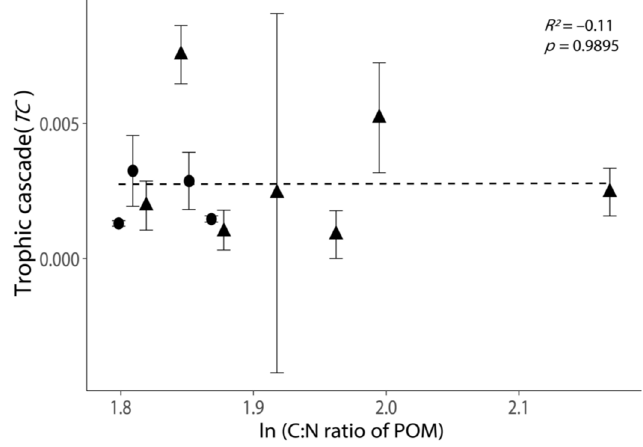
Figure 5. Relationship between the intensities of trophic cascades ( TC ) and the C: N ratio of POM. All values are shown as the mean ± 1 standard error. Negative values of TC were removed, as these experiments exhibited no trophic cascade. Triangular points indicate the TC calculated from the incubations with phytoplankton growth (Figure S2). The dash line indicates the best-fit regression line.